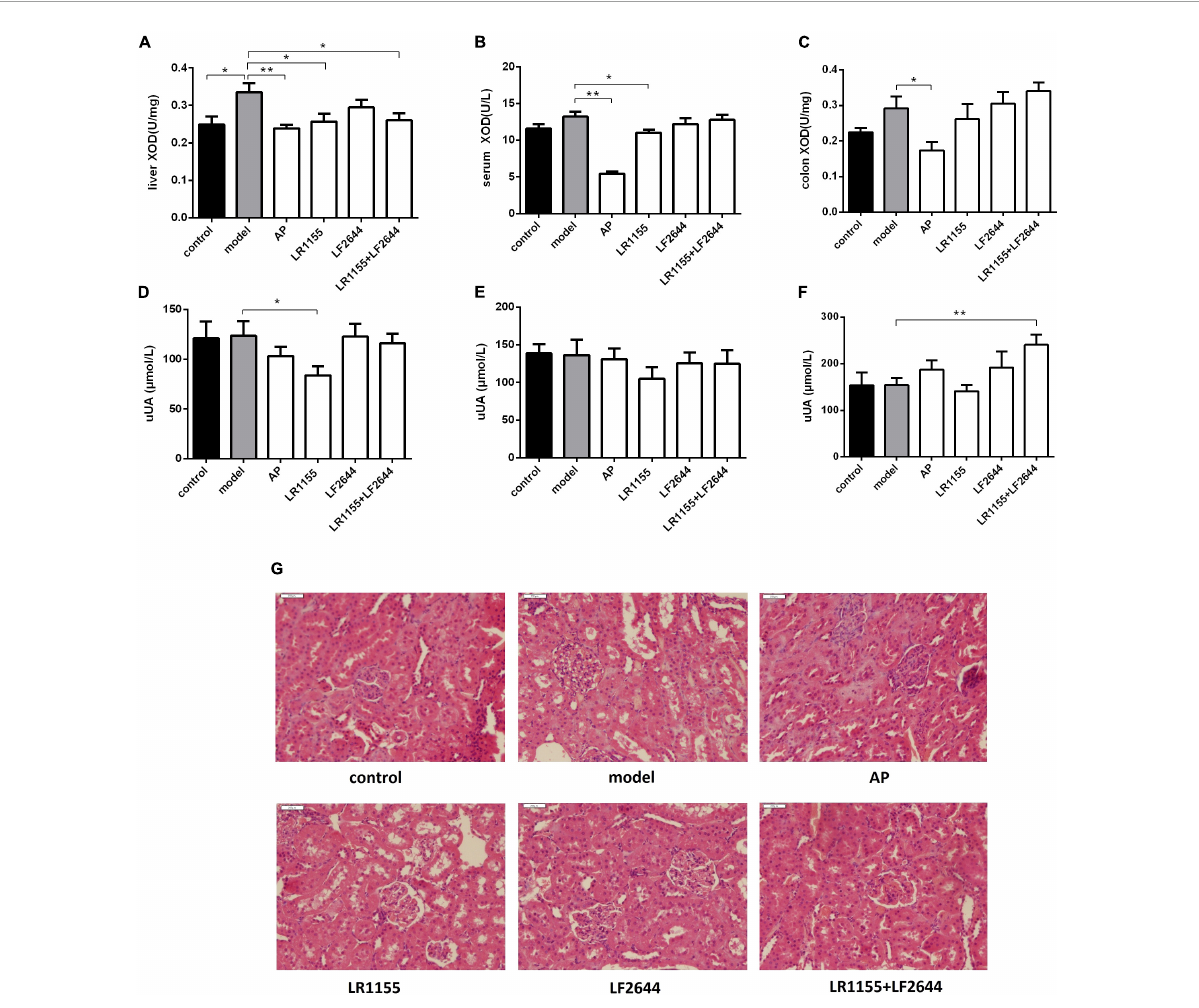
FIGURE2 Effects of LR1155 and LF2644 on XOD activities, urine UA levels and renal histology in hyperuricemia rats. (A–C) Activities of XOD in liver, serum and colon. (D–F) Urine UA levels on weeks 0, 1, and 4. (G) Kidney tissues by H&E stain observed at a magnification of 200 × . Data are expressed as mean ± SEM ( n = 10–12 per group). * P < 0.05, ** P < 0.01 vs. the model